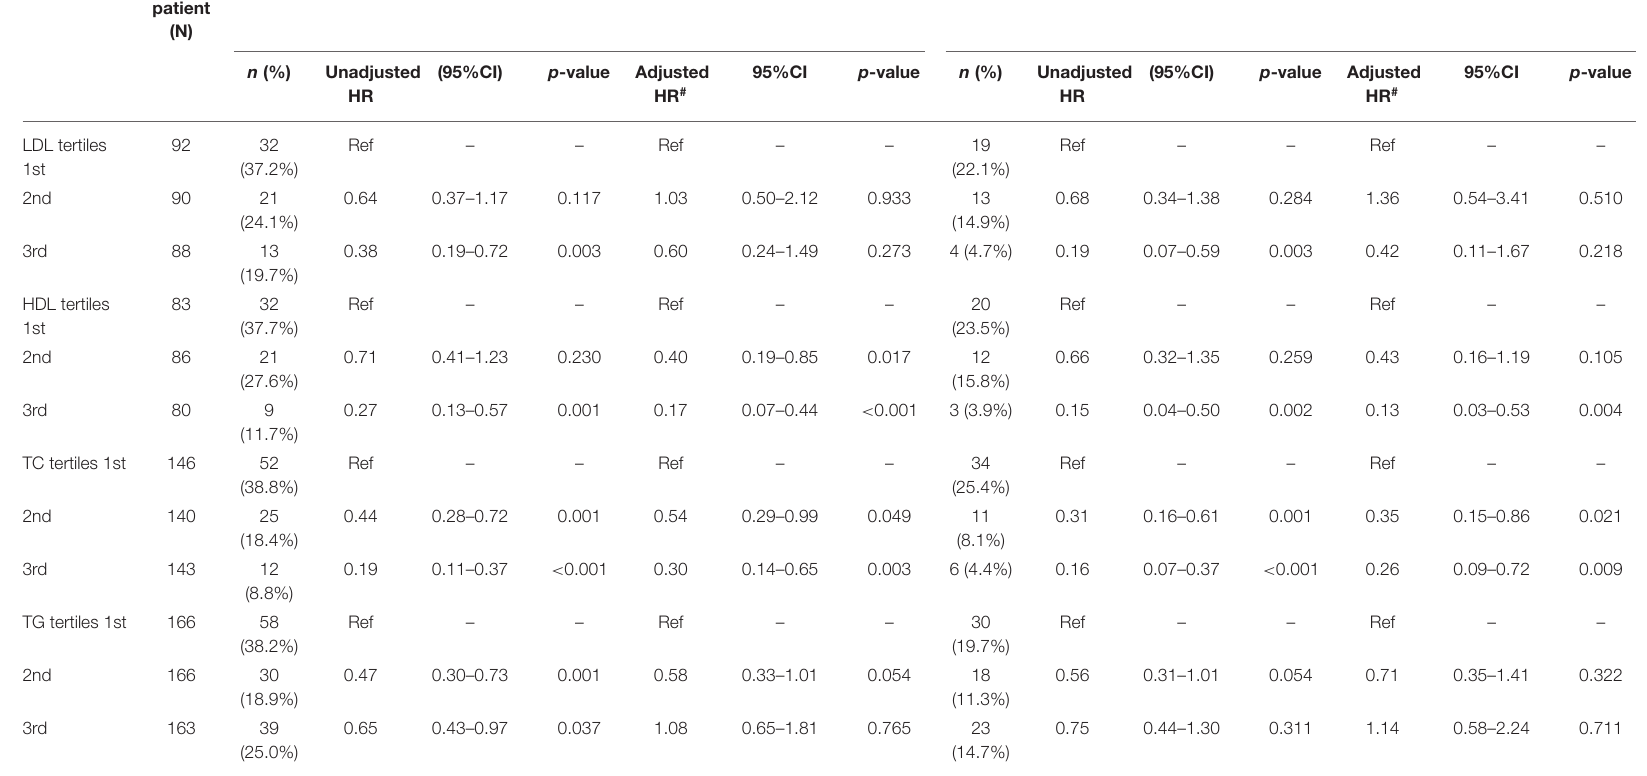
TABLE 3 | Association of serum lipid levels with all-cause and infection-related mortality by Cox regression analysis. Type of lipid